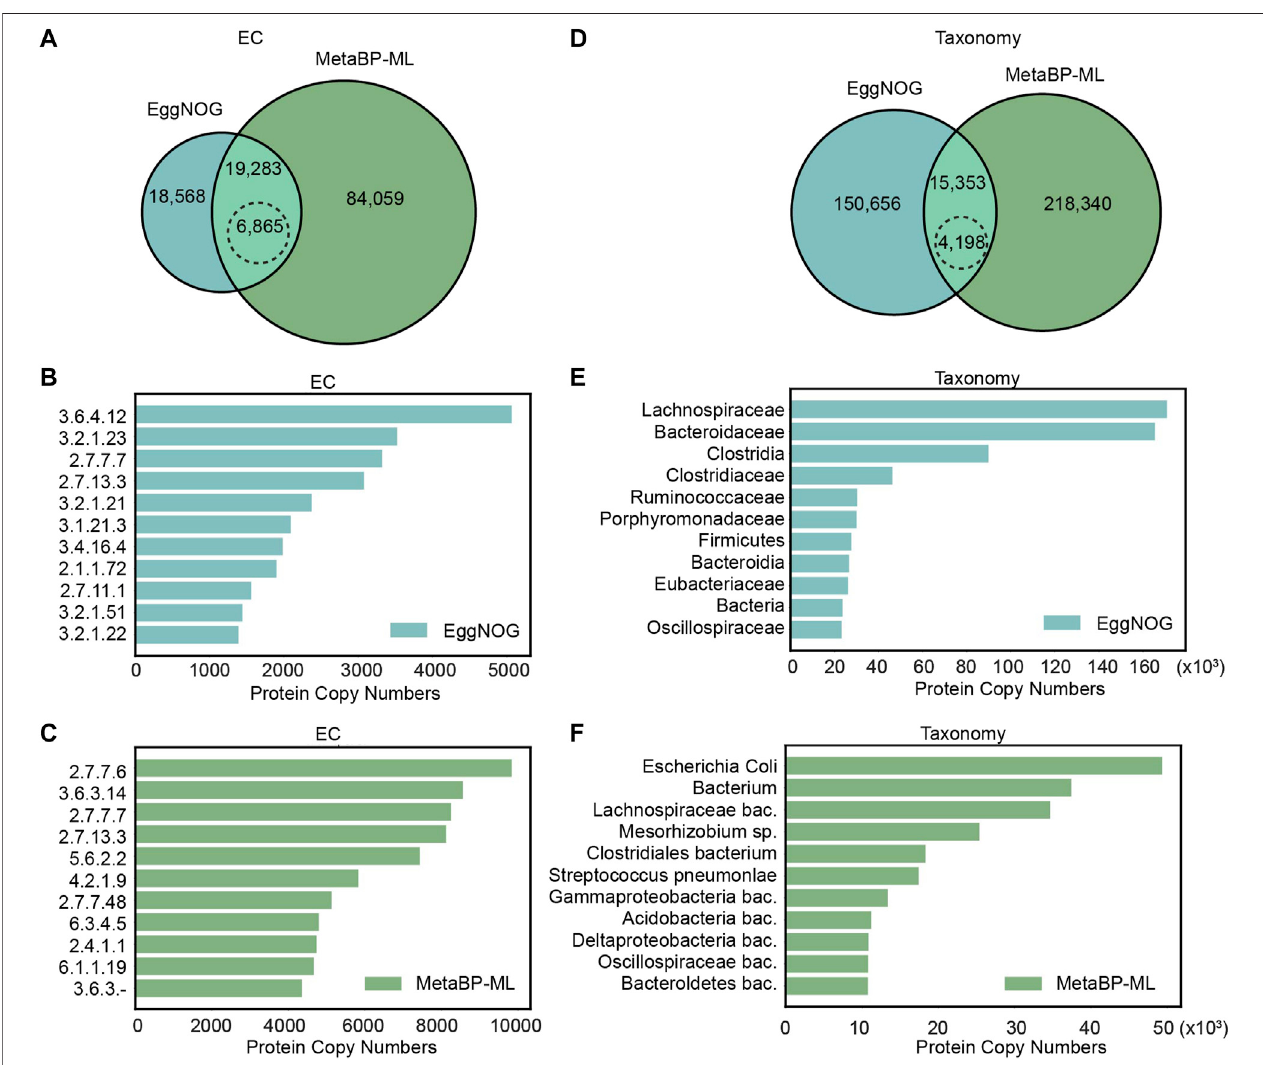
FIGURE3| Comparison ofsmallproteinannotationsfromeggNOGand metaBP-ML. (A) NumberofproteinscanbeannotatedwithECnumbersbyeggNOGand metaBP-ML. Atotal of6,865proteins indashed edgecircle areannotatedwithexactly thesameEC numbers. (B) Top 11EC numbers predicted from eggNOG (C) Top 11ECnumberspredictedfrommetaBP-ML. (D) NumberofproteinscanbeannotatedwithtaxonomytermsbyeggNOGandmetaBP-ML.Atotalof4,198proteinsinthe dashed edge circle are annotated with exactly thesamefamily names. (E) Top 11taxonomy terms predicted from eggNOG. (F) Top 11 taxonomy terms predicted by